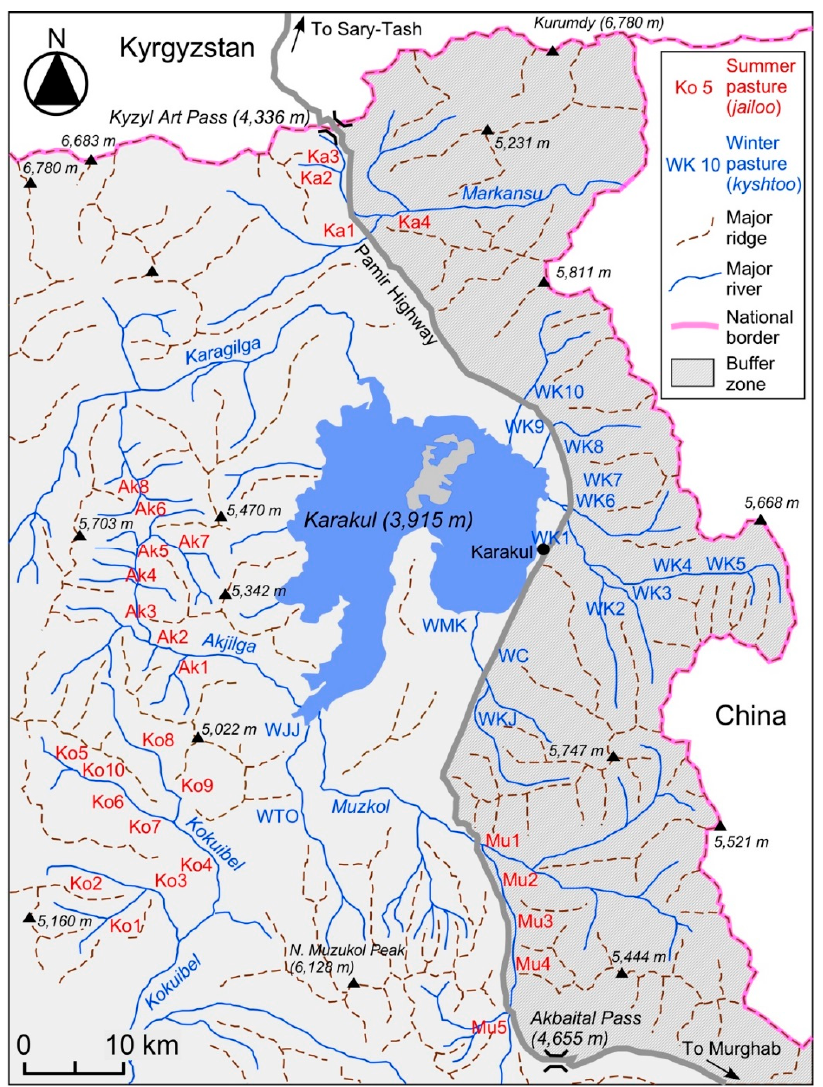
Figure 3. The locations of summer and winter pastures in Karakul (2015) and the buffer zone between the national border of China and the Pamir Highway. Summer pasture (jailoo ) = Ka1: